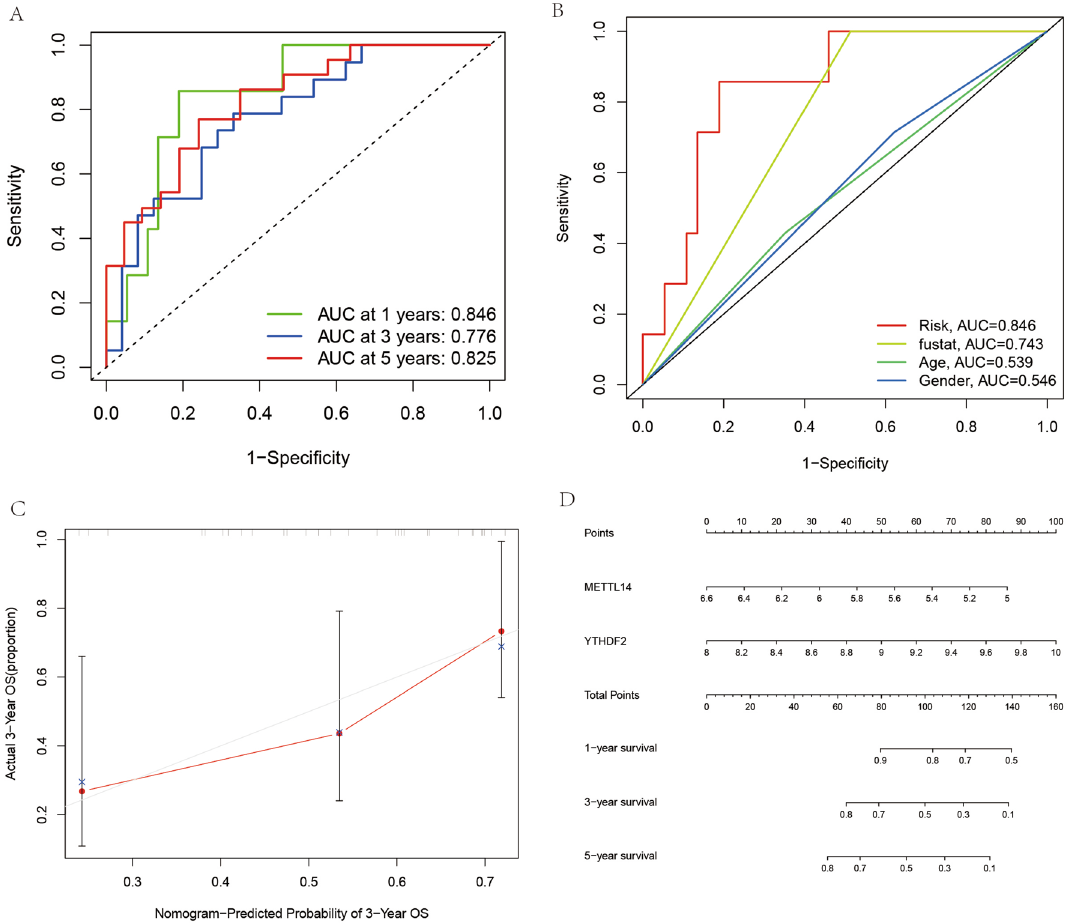
Figure 7. A test plot of the prognostic model of Ewing’s sarcoma. ( A ) represents the accuracy of predicting the probability of survival at 1,3 and 5 years. ( B ) indicates the accuracy of the diagnostic clinical information. ( C ) represents the calibration curve for predicting patient survival. ( D ) represents the column line plot for predicting the probability of patient